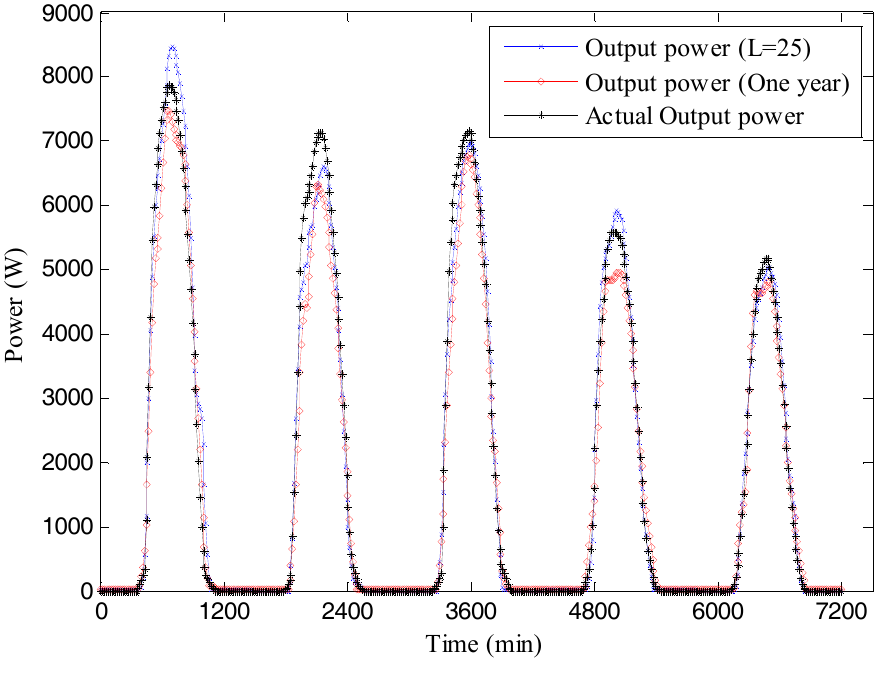
Figure 10. Comparison of forecasting results.